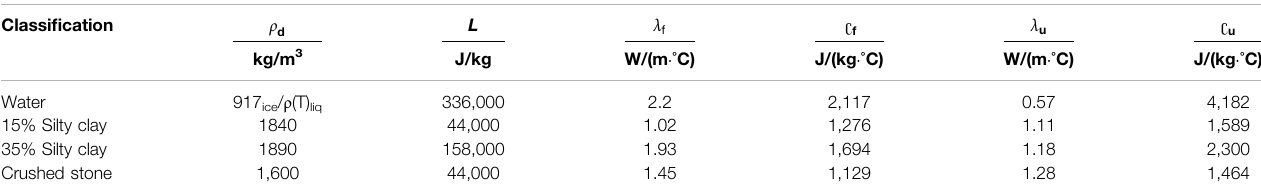
TABLE 1 | Thermal parameters of water and soil (Xu, 2001; Cao, 2015).